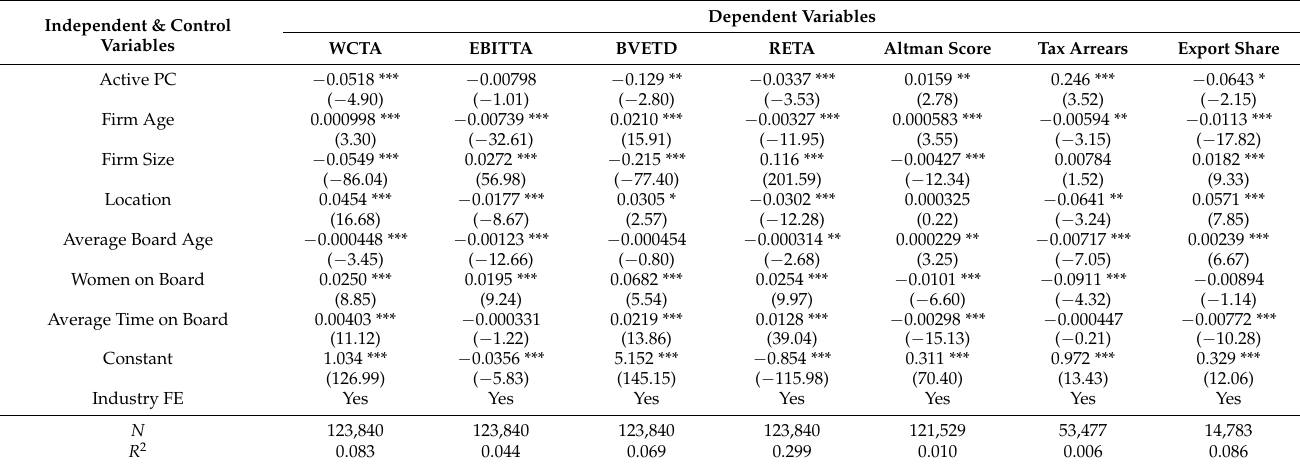
Table 3. OLS regressions with seven different dependent variables (from year 2019) and Active PC as the independent